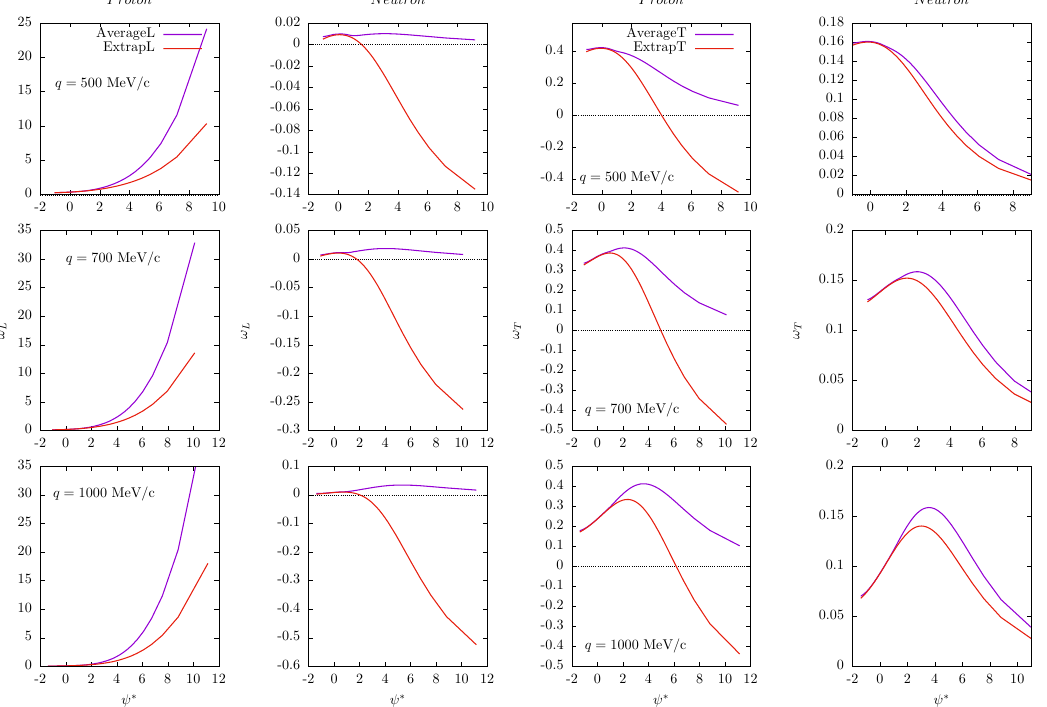
ExtrapLAverageL